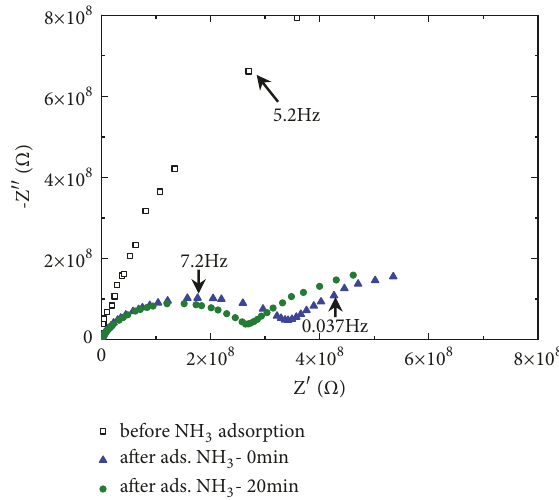
Figure 2: Nyquist plot of sulfated zirconia before and after loading ammonia at 383 K.